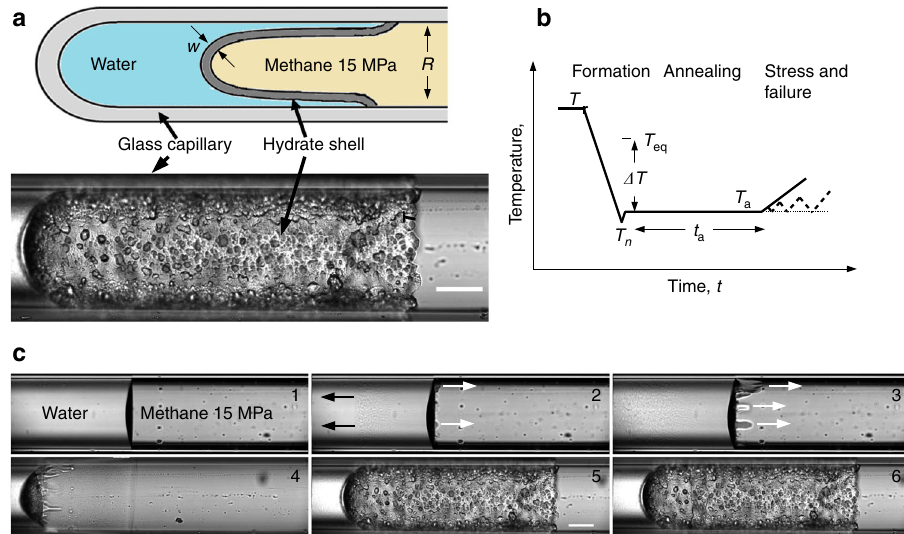
Fig. 1 Principal steps of stressing a microns thick methane hydrate sleeve. a Schematic and a typical sample in a glass capillary. A thin shell of methane hydrate (grey) separating water (blue) from the guest gas (yellow, pressure constant) is grown from the meniscus in a closed glass capillary, until it anchors to the glass. Scale bar 100 μ m; b Steps in the formation and stressing of the hydrate shell. Methane-saturated water ( ≈ 15 MPa, room temperature, T r ) is quenched until nucleation of the hydrate as a cap on the meniscus (here T n ≈ − 23 °C), initiating crystallization of micro-crystals in the water (black arrows in c ) and a polycrystalline halo growing to the right on a fi lm of water (white arrows). After annealing (hours) at temperature T a ≥ T n , the sample is warmed ( ≈ 1 K, at ≤ 1 K/min), or cycled to increasing temperatures (dashed line). Thermally induced contraction of the water causes tensile stress of the halo, who ’ s elongation is measured under a microscope; c Snapshots of the process: 1: initial state; 2: nucleation of the cap, crystallites and halo; 3 and 4: spreading of the halo; 5 a late stage of annealing; 6: moment of failure at the serrated line near the former